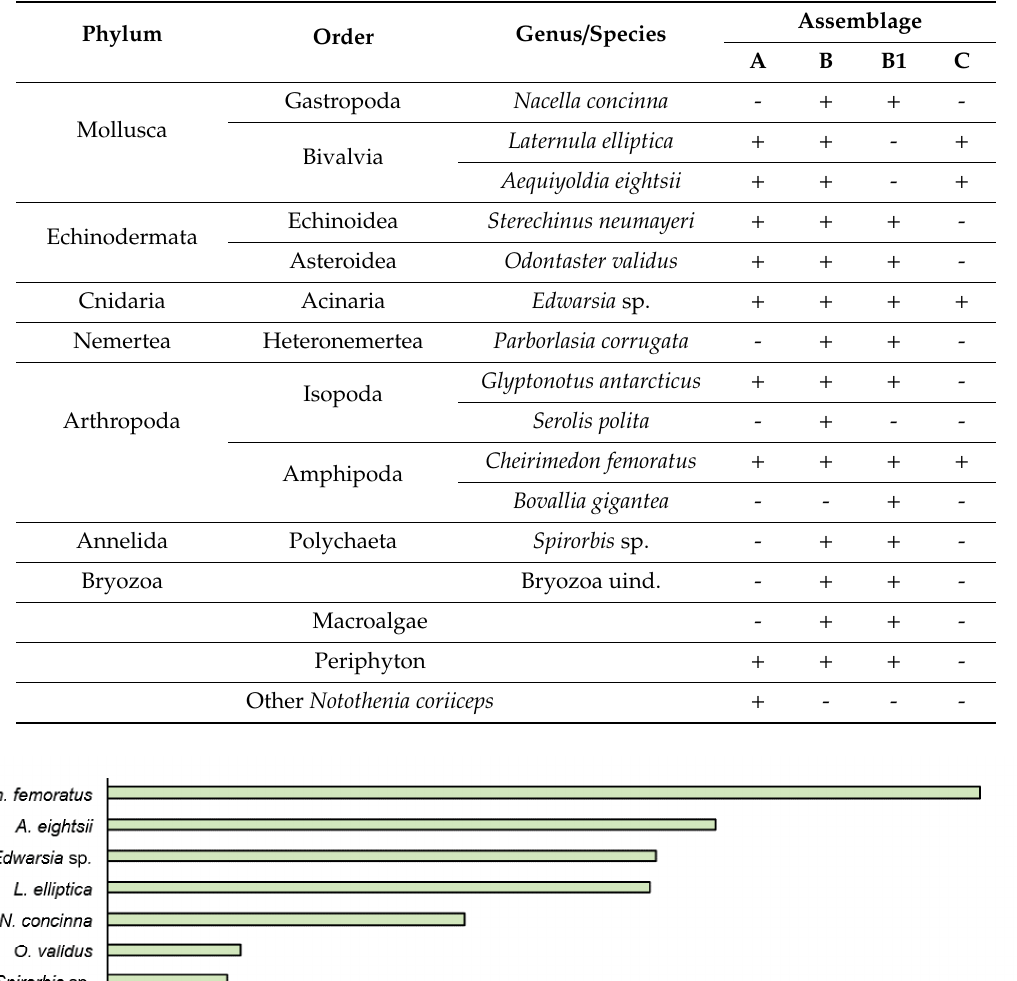
Table 2. Benthic taxa present in assemblages recognized in Herve Cove. (A) Soft bottom—sandy, silty and clay deposits, (B) Hard bottom—rocky and rocky-sandy deposits, (B1) Boulders, (C) Soft bottom vicinity of stream.